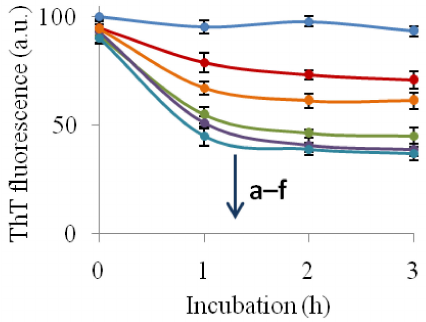
Figure 6. Effects of AsA and its degradation products on the kinetics of fibril destabilization. The reaction mixtures were incubated at 37 ◦ C for the indicated times. Curve ( a ), insulin fibrils only; ( b – f ), insulin fibrils incubated with AsA, AsA24h, AsA48h, DKG, and DHA, respectively. All data were normalized to the maximum ThT value, and shown as mean and standard error (n =